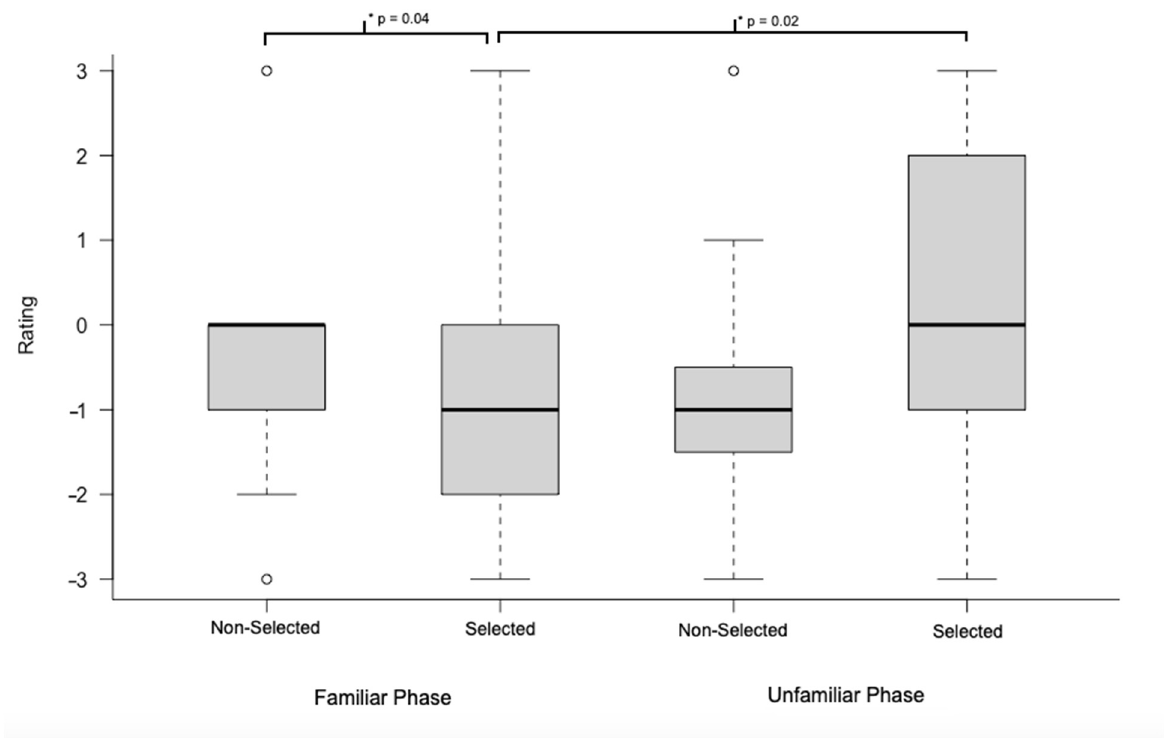
Figure 2. Within-group differences as well as between-group differences in the non-selected horses and selected horses are shown. The bold line represents the mean, and circles are outliers. *: Significant